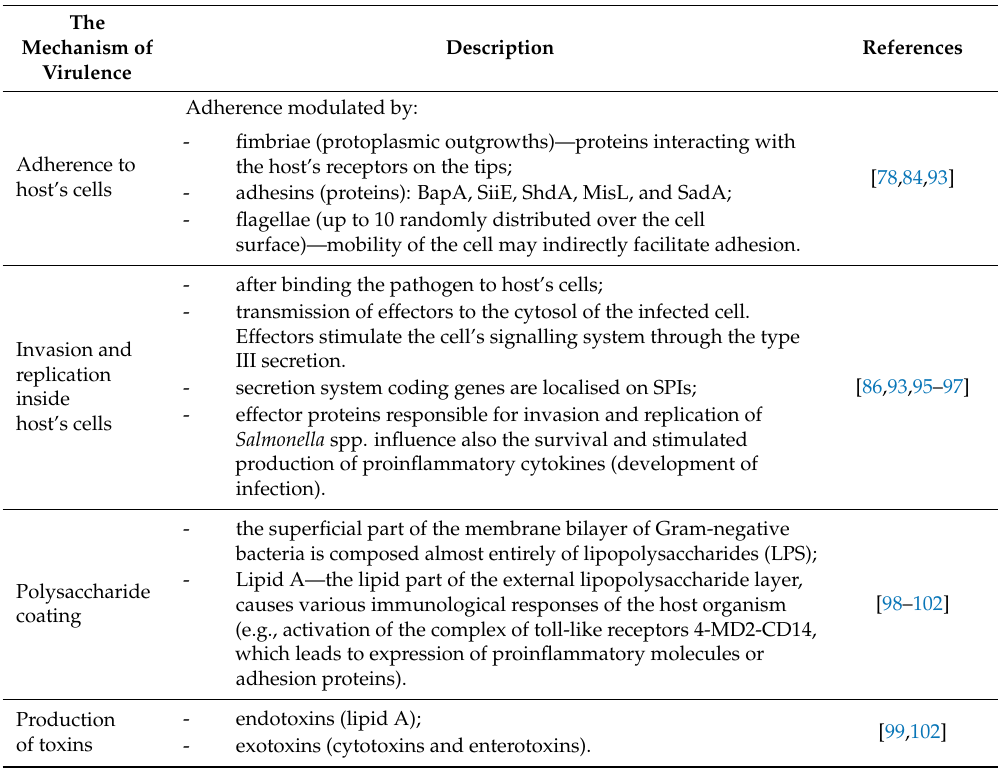
Table 2. Factors determining the virulence of Salmonella genus